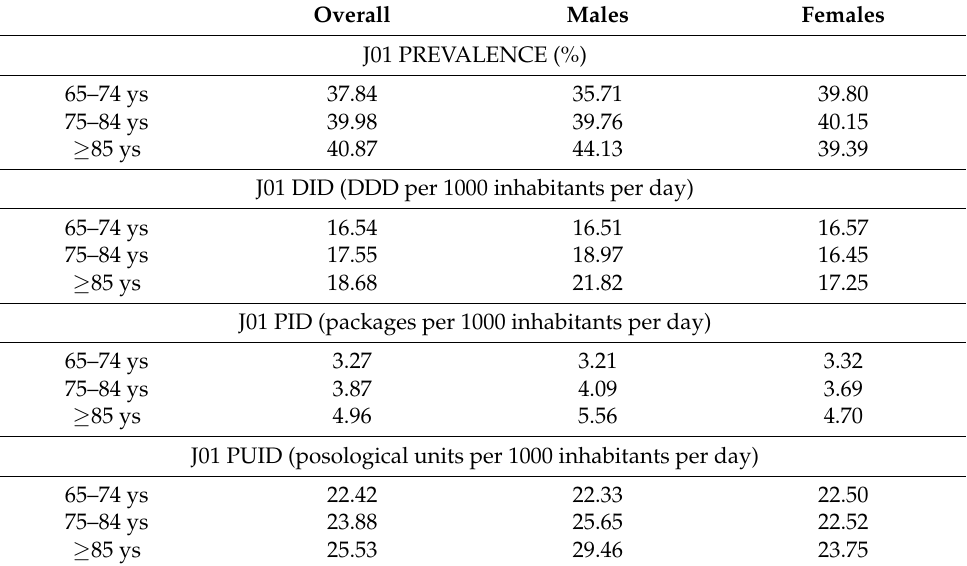
Table 2. Antibiotic prevalence of users and consumption, by sex and age groups. Overall Males